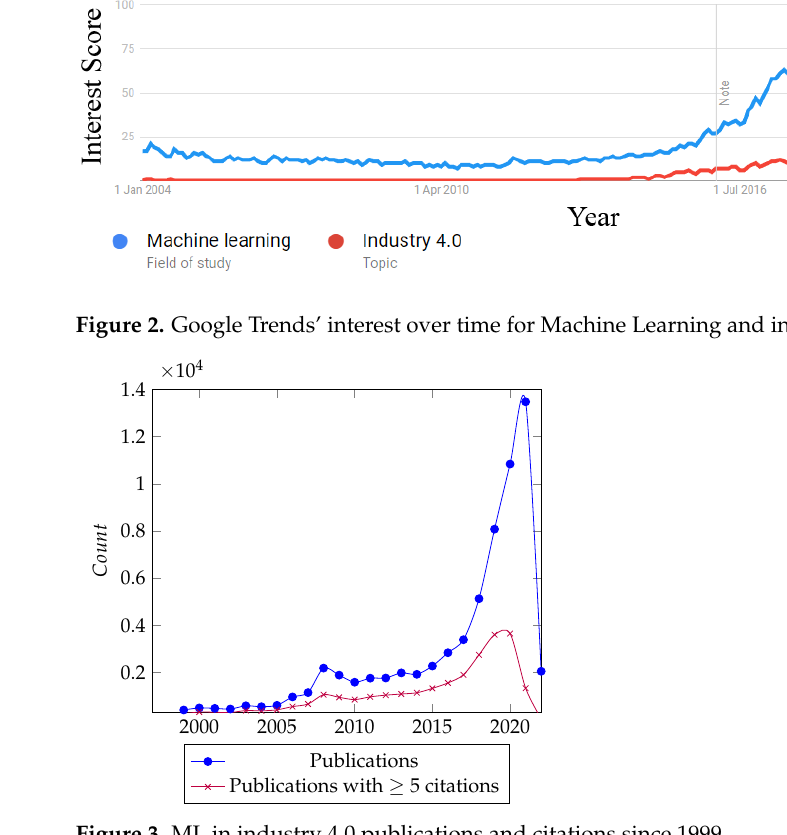
Figure 3. ML in industry 4.0 publications and citations since